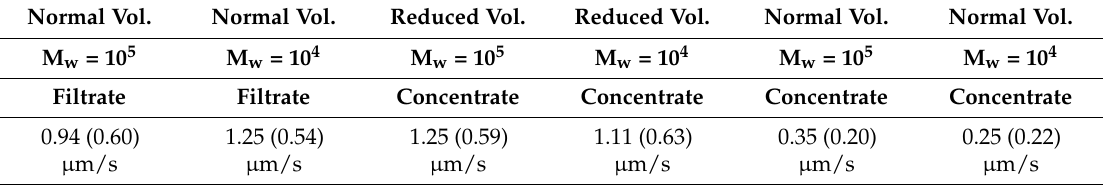
Table 5. Average growth rate of ice particles in the case where the HPLC6 solution was filtered. Normal Vol. Normal Vol. Reduced Vol. Reduced Vol. Normal Vol. Normal Vol. M w = 10 5 M w = 10 4 M w = 10 5 M w = 10 4 Filtrate Filtrate Concentrate Concentrate Concentrate Concentrate 0.94